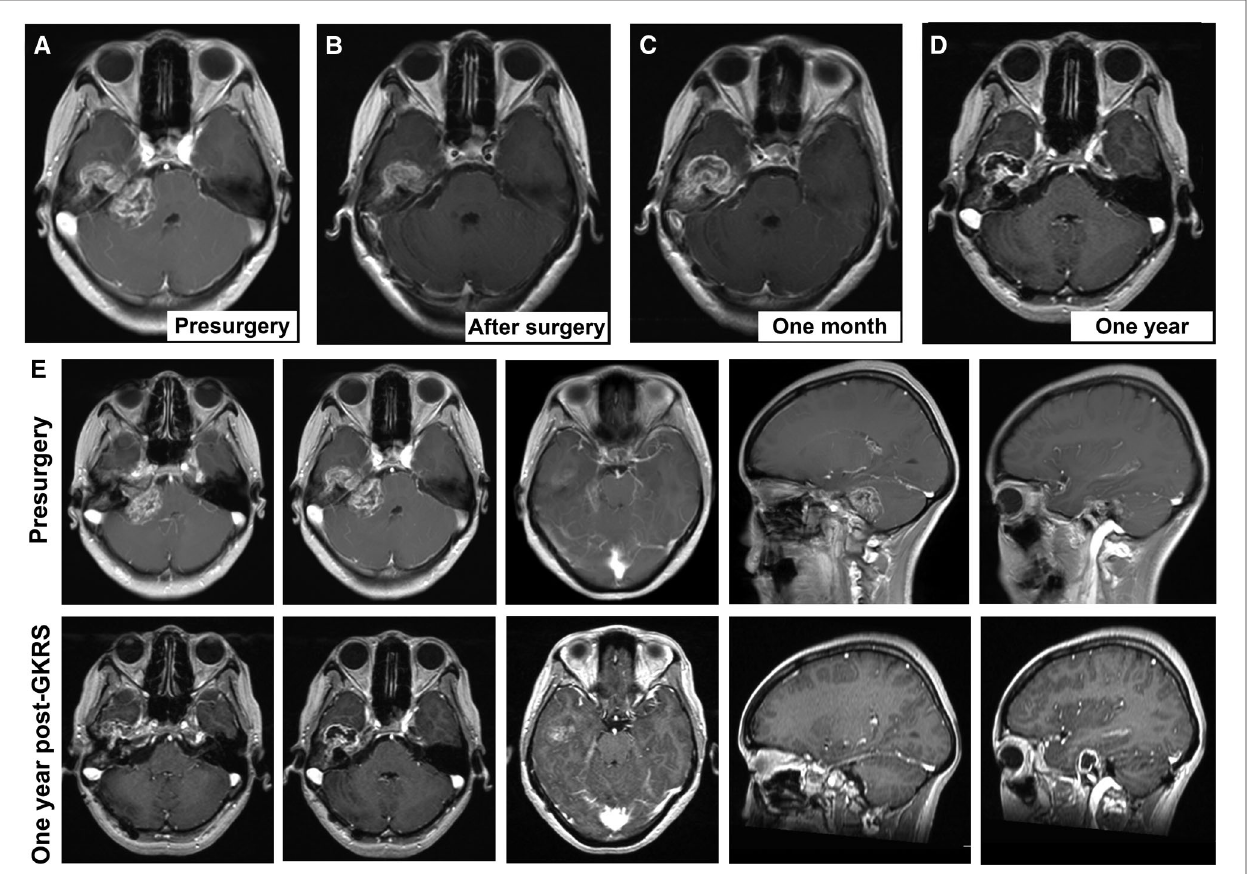
FIGURE 3 | Consecutive follow-up MRI. ( A ) Presurgical scan; ( B ) MRI scan after microsurgery; ( C ) MRI scan one month after gamma knife radiosurgery; ( D ) MRI scan one year after gamma knife radiosurgery. ( E ) the comparison of MRI fi ndings between pre-surgical scan and the scan one year after gamma knife radiosurgery.